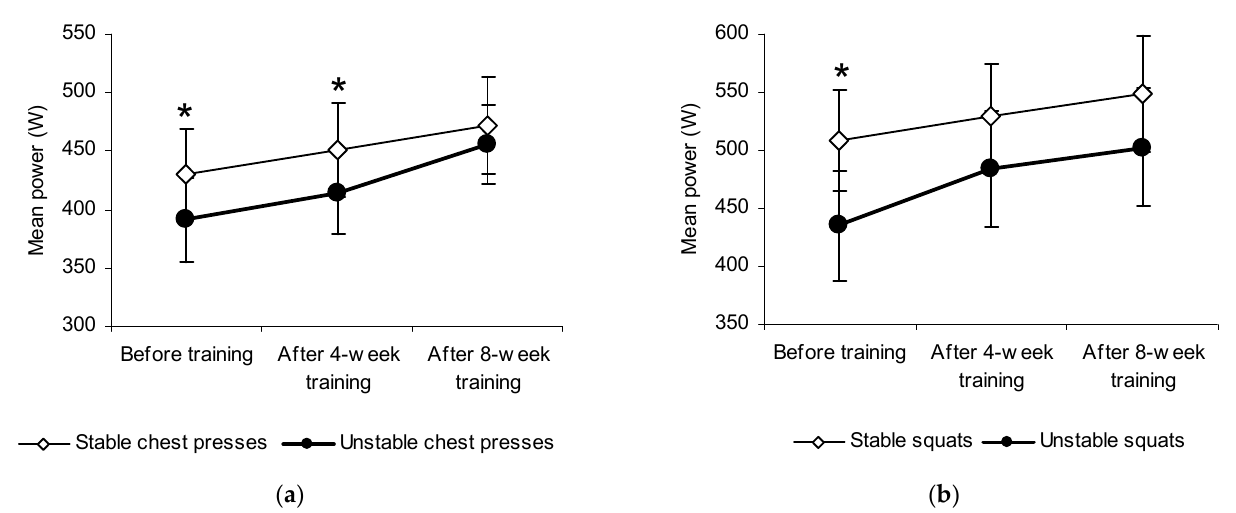
Figure 1. Maximal values of mean power during ( a ) chest presses and ( b ) squats before and after 4-week training under stable and unstable conditions.